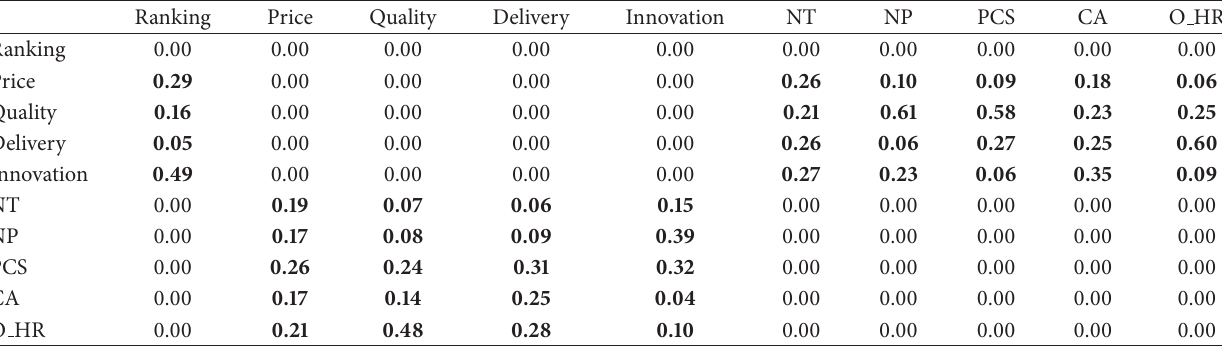
Table 9: Weighted supermatrix of the applied